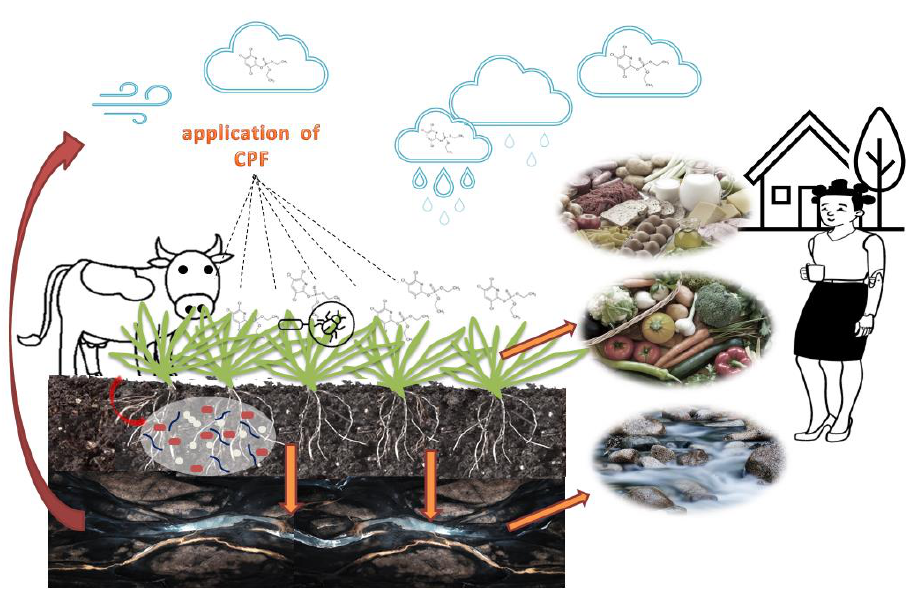
Figure 1. The occurrence and permeation of CPF in the environment.